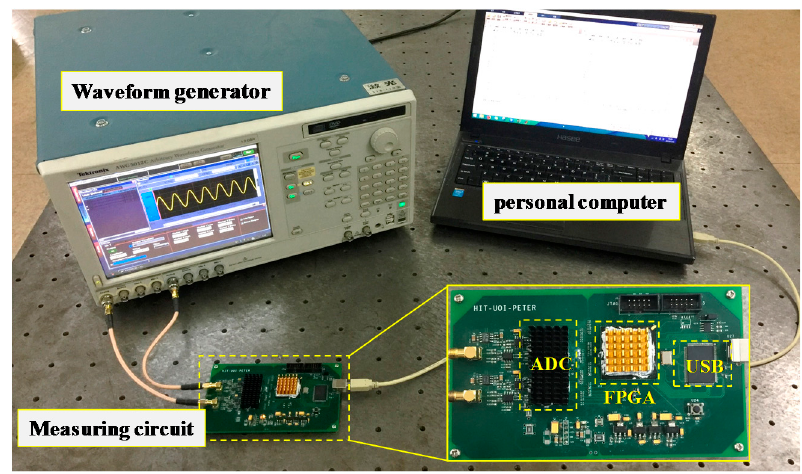
Figure 3. Experimental setup for validating the proposed measurement method of nonlinearity in heterodyne laser interferometers. ADC, analog-to-digital converter, FPGA, Field-Programmable Gate Array, USB, Universal Serial Bus.